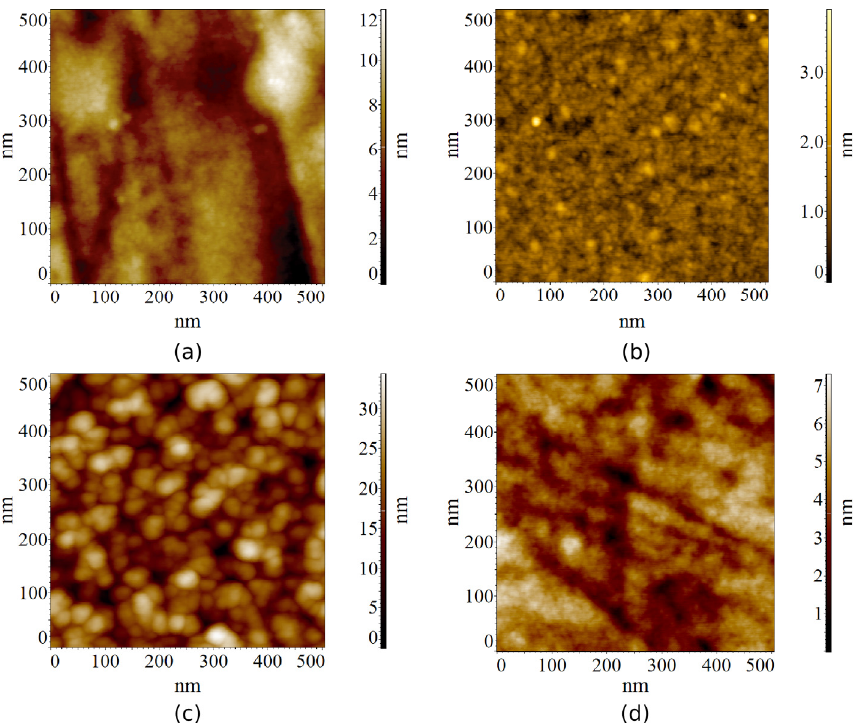
Figure 7. AFM images of the coatings prepared from SPNBI-I,III ( a ) and its K ( b ), Ca ( c ), and Cr ( d ) salts.